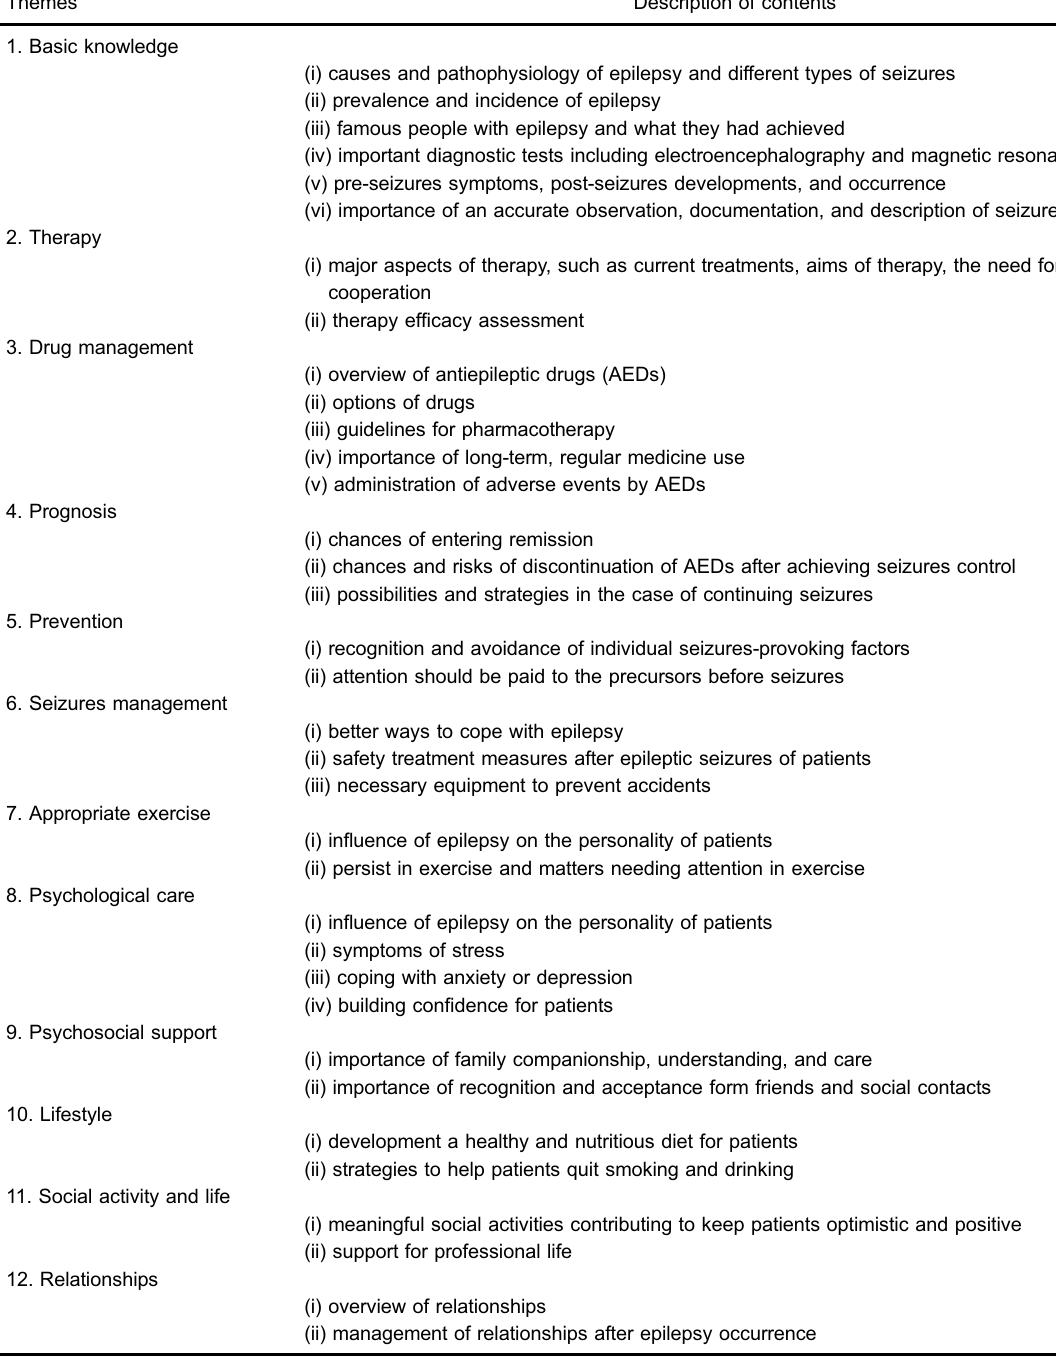
Table 1. Themes in the educational sessions of caregiver intensive education program